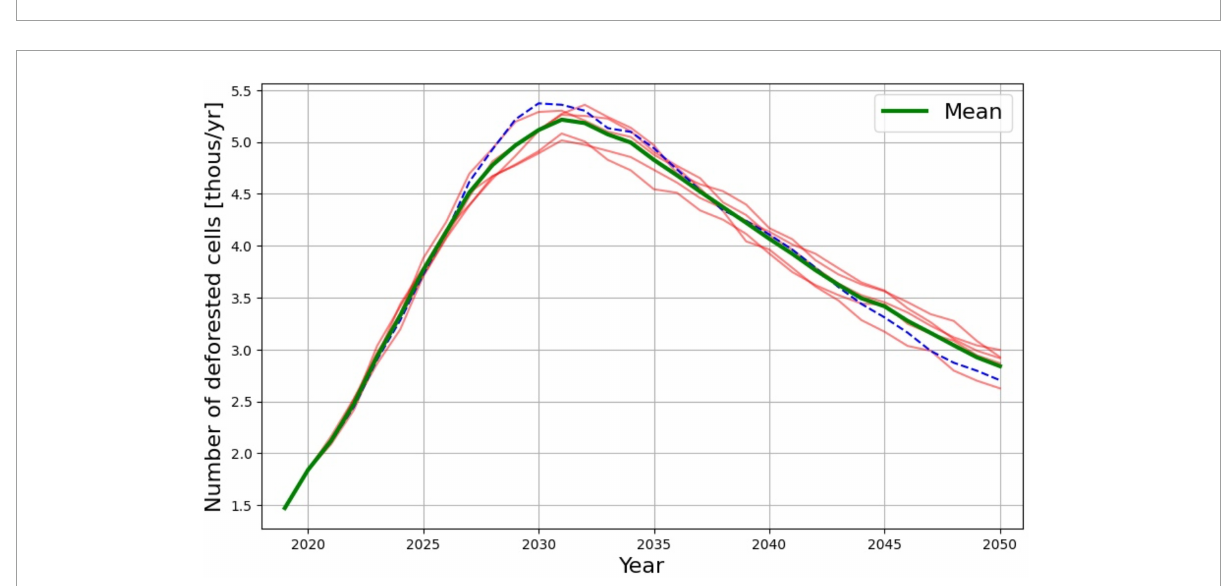
FIGURE7 Deforestation scenario with threshold N = 0 . 35. Deforestation rates are the number of deforested cells per year. The green line represents the mean of stochastic simulations. The dashed blue line represents a stochastic simulation used in the “Results” section. Other lines are representative of individual model runs. The spread of stochastic runs around the mean is